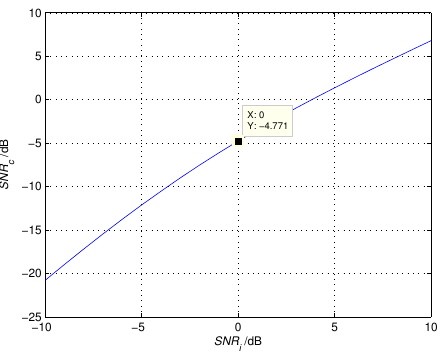
Figure 6. The relationship between the SNR after cross-correlation ( SNR c ) and the SNR of echo signal ( SNR i